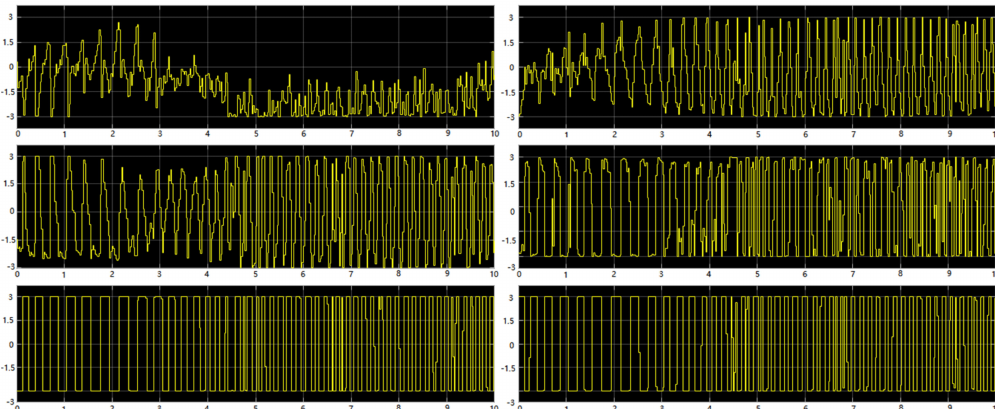
Figure 6. The torque applied to the leg joints during a walk. The three pictures on the left show the torque applied to the left hip joint, left knee joint and left ankle joint from top to bottom. The three pictures on the right show the torque applied to the right hip joint, right knee joint and right ankle joint from top to bottom. The abscissa represents the movement time in seconds.